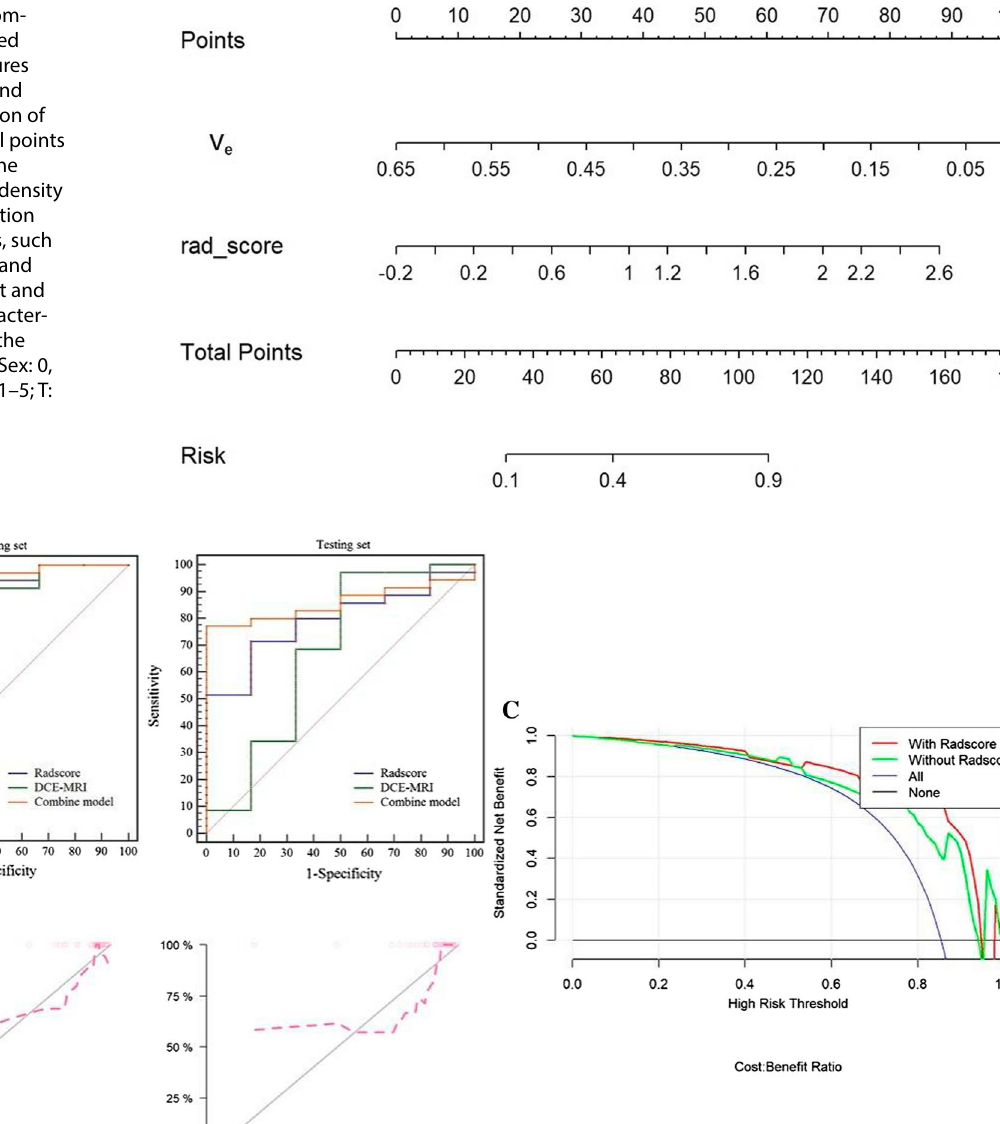
Fig. 5 A ROC analysis to discriminate responders from non-responders for radscore, clinical model and nomogram. ROC curves for nomo- gram had the highest area under the ROC curves in both the training set and the test set. B calibration curve of nomogram in the training set and the test set. C net benefit curves for nomogram compared with models of DCE-MRI andradscore. Y axis means clinical benefit, X axis means the risk of prediction response. None means that none of clinical decision had been taken. All means that random project had been taken. The clinical benefit of nomogram was the highest among nomogram, radscore and clinical model when the clinical risk lower than